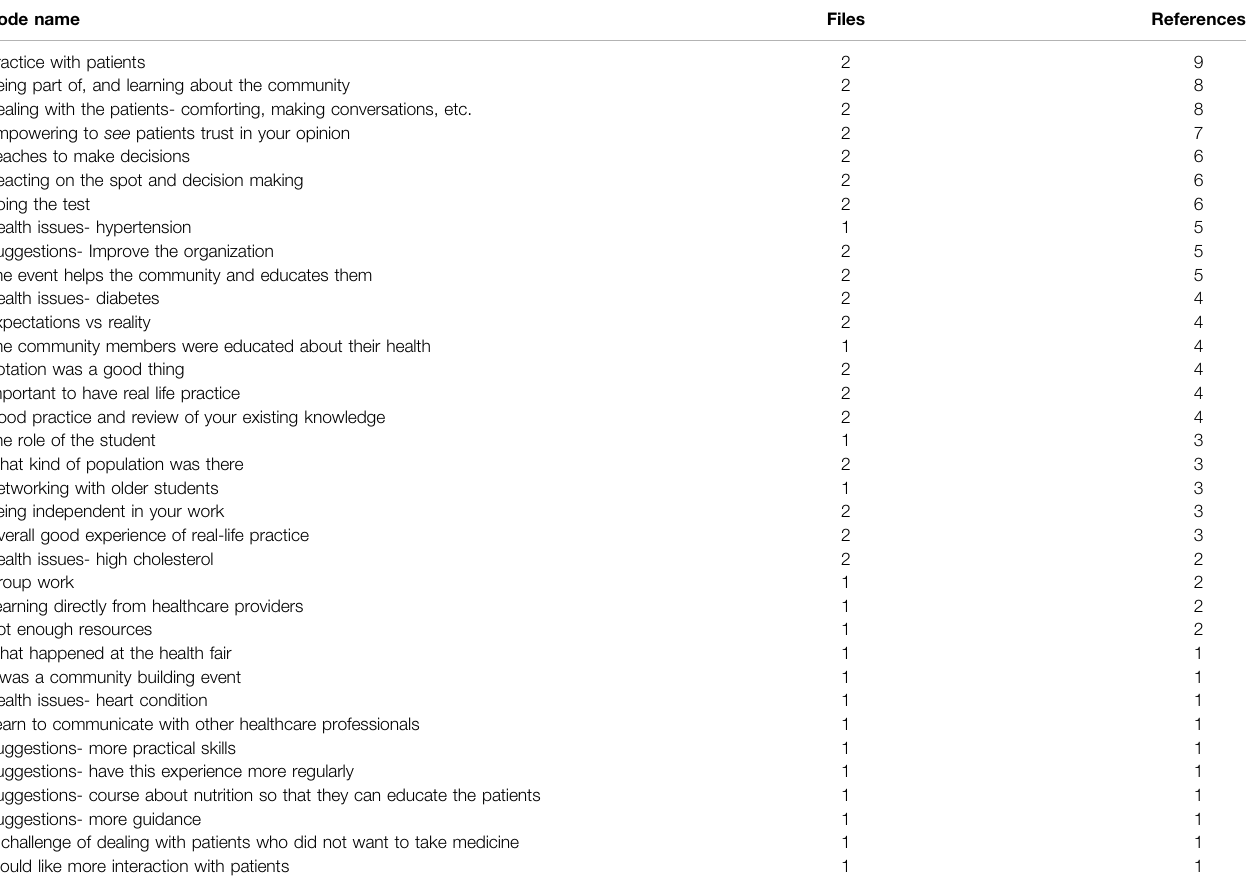
TABLE 3 | Initial, line-by-line